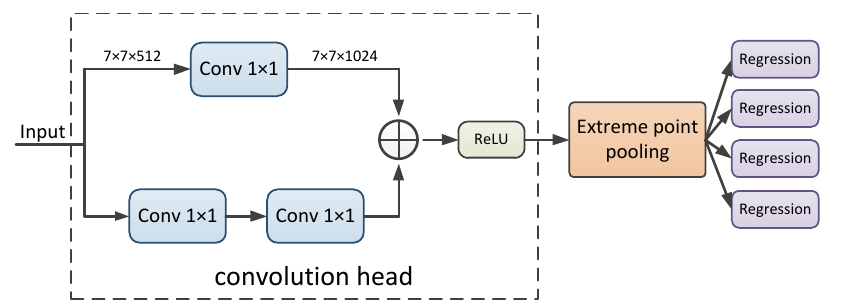
Figure 6. Structure of the boundary regression module.